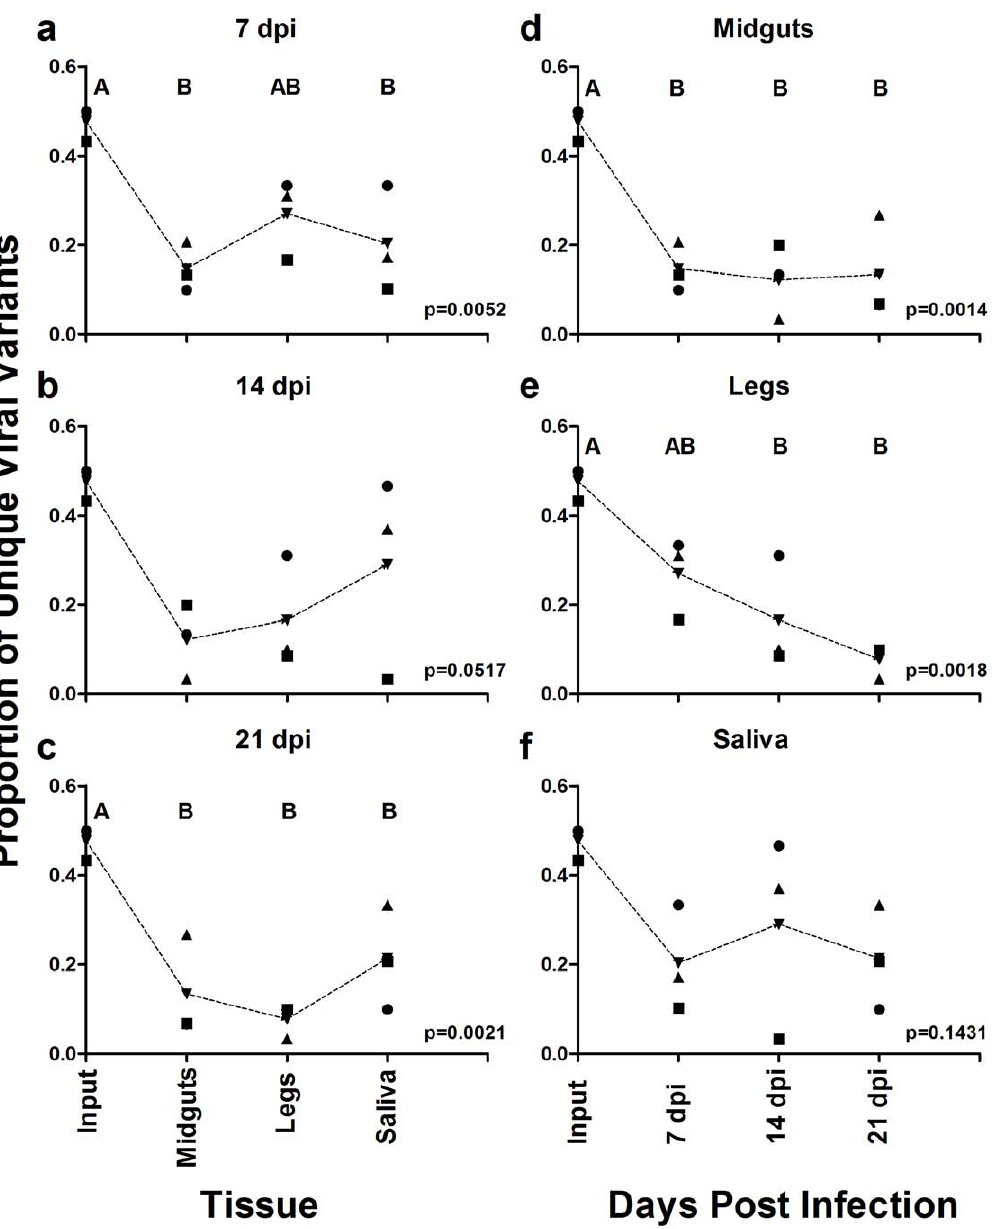
Figure 2. Proportion unique viral variants by time and tissue. The proportion of unique viral variants was determined for each sample and plotted by either days post infection (7 dpi (A), 14 dpi (B), & 21 dpi (C)) or by tissue type (midguts (D), legs (E), & saliva (F)). Dotted lines connect means for each sample set. P-values were determined by ANOVA using Tukey’s multiple comparison post test. Letters above sample sets represent statistically significant groupings (p-value , 0.05). Figures without letters denote that samples were not significantly different from one